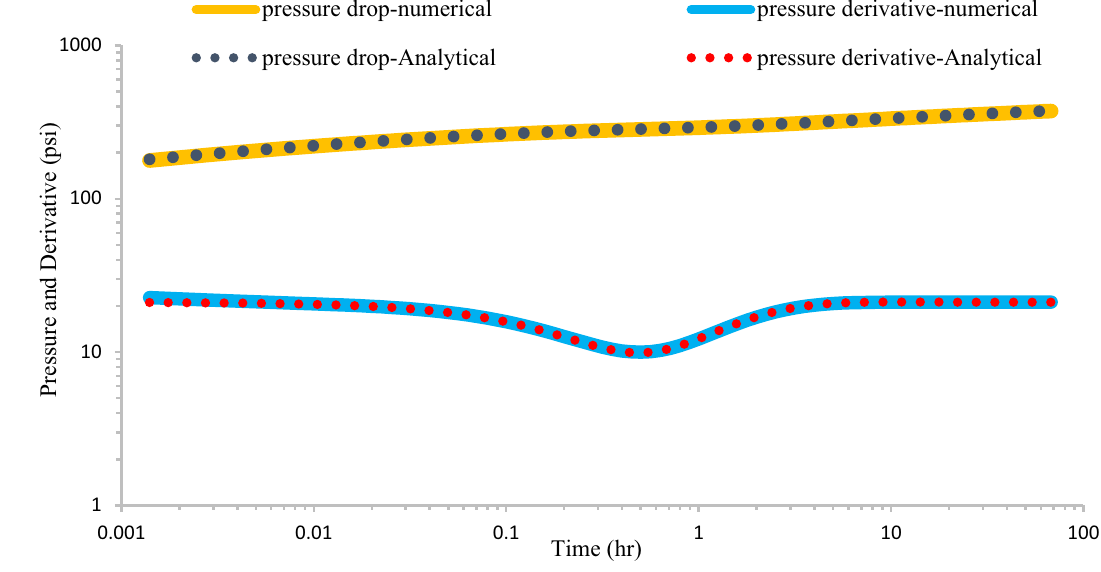
Fig. 11 Matching pressure and pressure derivative plots in log–log scale of the base case for naturally fractured reservoir’s model